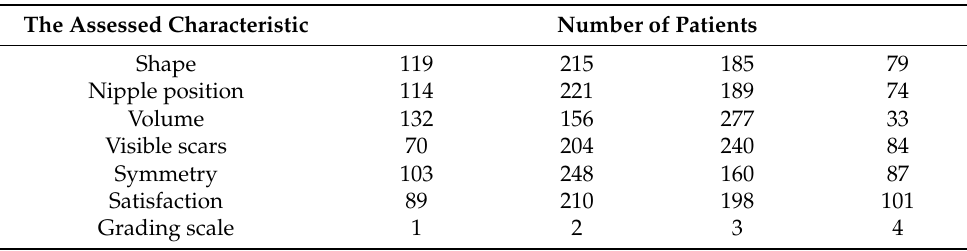
Table A6. Subjective scale of the outcomes of the operation completed by the patients allocated in the control group 6 months after the surgery.